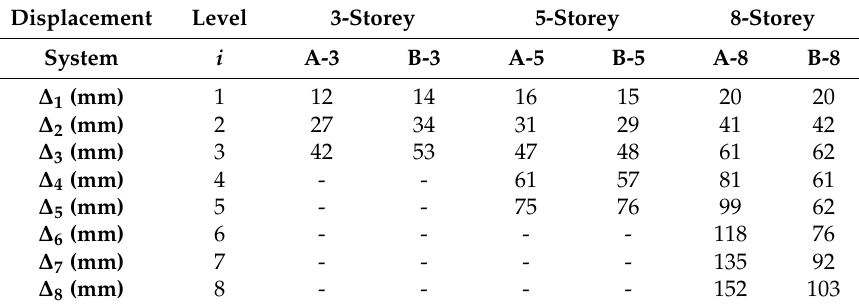
Table 6. Lateral displacements at displacement limiting state (DLS).